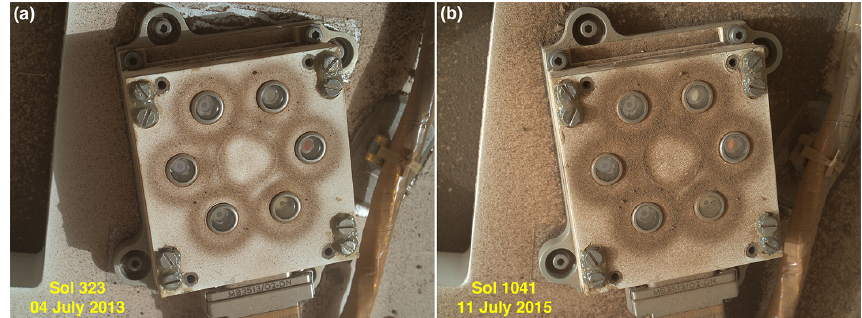
Figure 12. Comparison of dust coatings on the Rover Environmental Monitoring Station ultraviolet (REMS UV) sensor (Gómez-Elvira et al., 2012) between sols 323 and 1041. On a ∼ 60-sol cadence, MAHLI images the REMS UV sensor to monitor dust coverage over this zenith- viewing sensor and its internally mounted ring-shaped magnets. In addition, on sol 526, MAHLI was employed to image the REMS meteoro- logical boom no. 1, via a maneuver challenging to robotic arm positioning, to look for signs of damage on the boom that might have occurred during landing and led to the failure of the boom 1 wind sensor. (a) The sol 323 picture is MAHLI image 0323MH0000950010104076C00, illuminated by sunlight from the right. (b) The sol 1041 view is MAHLI image 1041MH0000950010400265C00, illuminated by sunlight from the